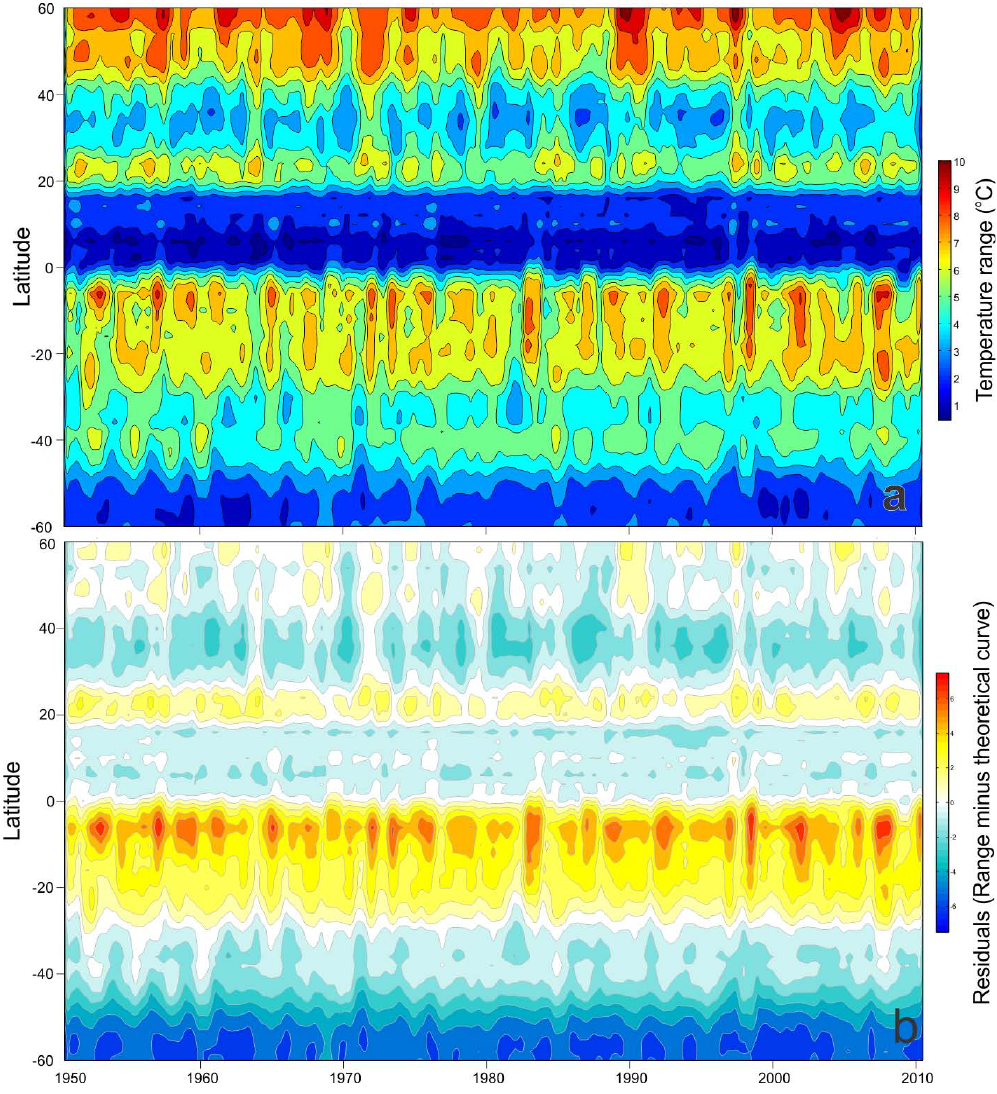
Fig. 3. Hovm¨oller diagram of the SST range (TA, (a) ), and the residuals (TR) calculated from subtracting the theoretical curve from the range (b)